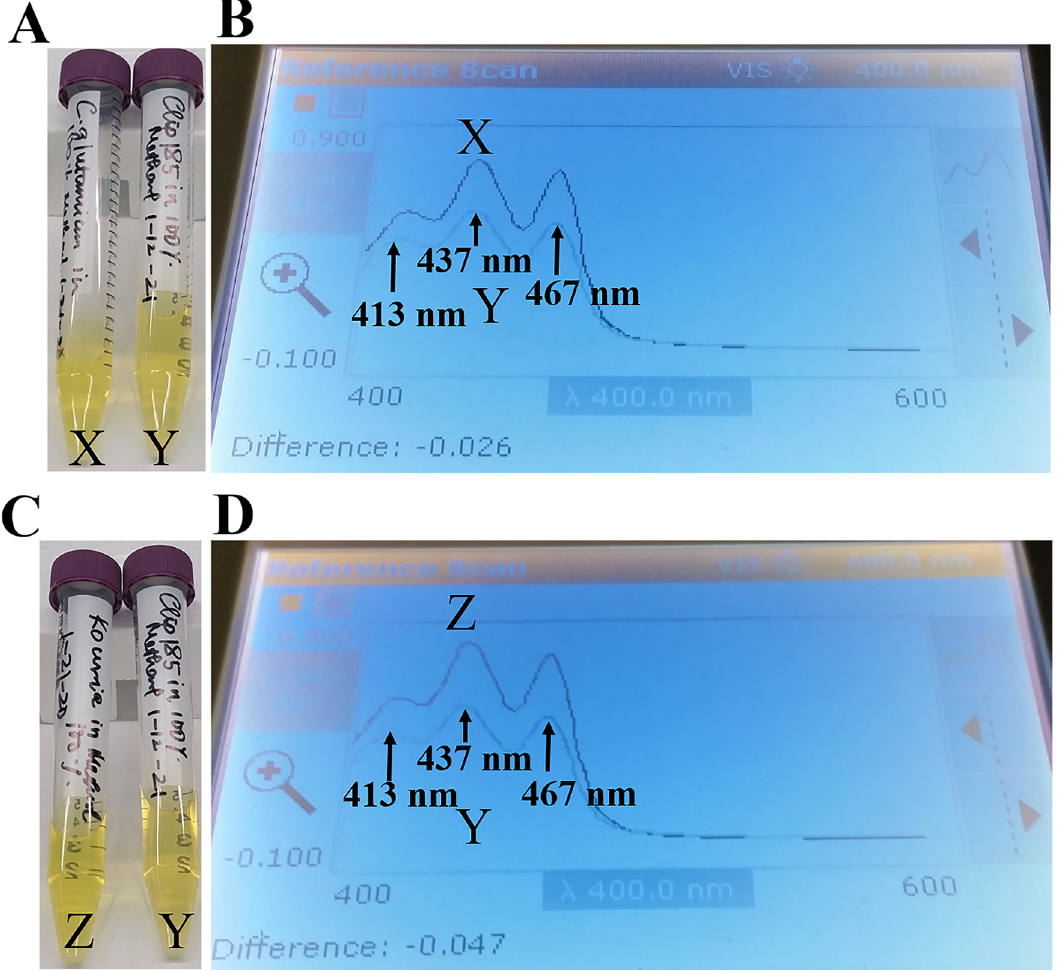
Figure12.SpectrophotometricanalysesofextractedpigmentsofClip185. (A)Falcontubescontainingmethanol- extracted pigments of Corynebacterium glutamicum (X) and Clip185 (Y). (B) Absorption spectra of extracted pigments C. glutamicum (X, dark blue spectrum) and Clip185 (Y, pale blue spectrum). (C) Falcon tubes containing methanol- extractedpigmentsof Kocuriarhizophila (Z)andClip185(Y).(D)Absorptionspectraofextractedpigments K.rhizophila (Z, dark blue spectrum) and Clip185 (Y, pale blue spectrum). Three major absorption peaks of decaprenoxanthin are